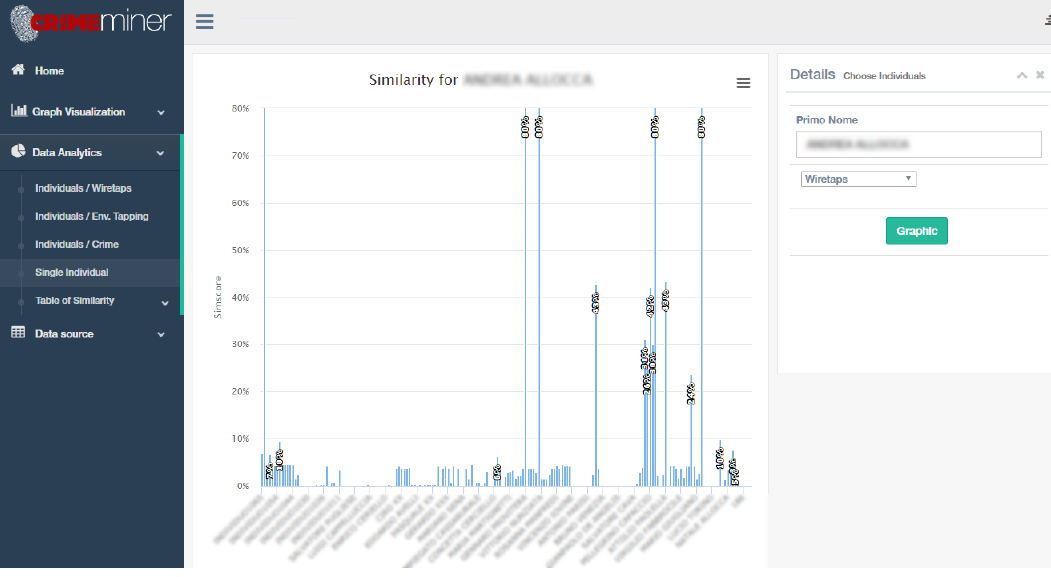
Figure 7. Bar plot of a single individual SimRank with all